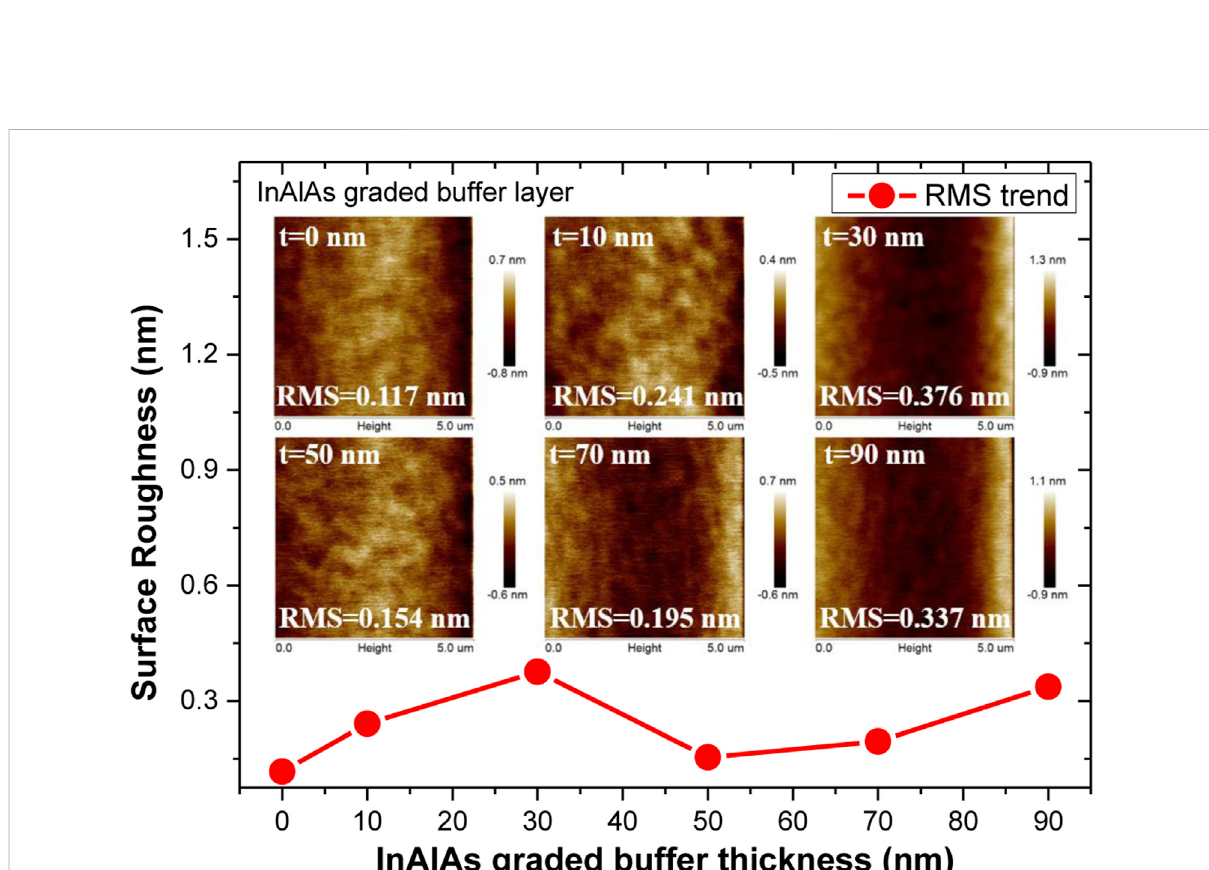
FIGURE 5 The HRXRD swing curve and the AFM images of In 0.66 Ga 0.34 As.